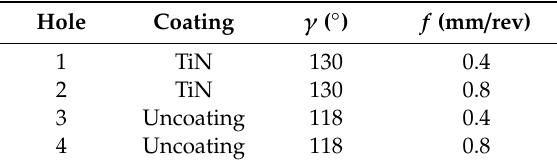
Table 6. Sectioned holes and cutting parameters